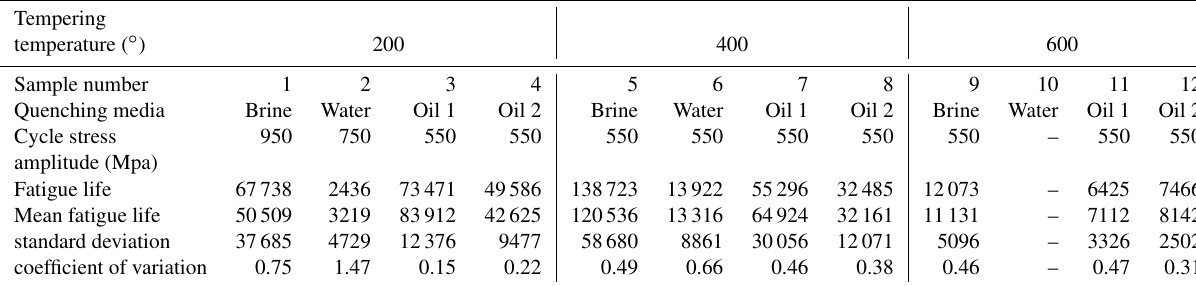
Table 4. Test parameters and fatigue life of the samples of which the fracture were observed. Tempering